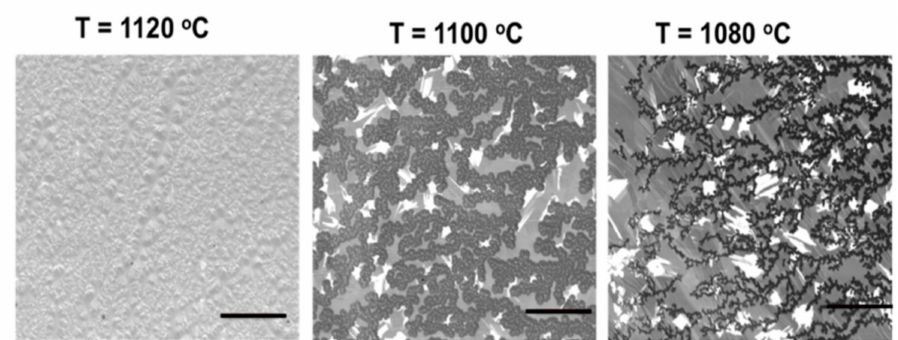
Figure 6. SEM micrographs of deposited graphene on liquid Sn showing the evolution of the graphene coverage due to the increase in growth temperature. Scale bar: 20 µ